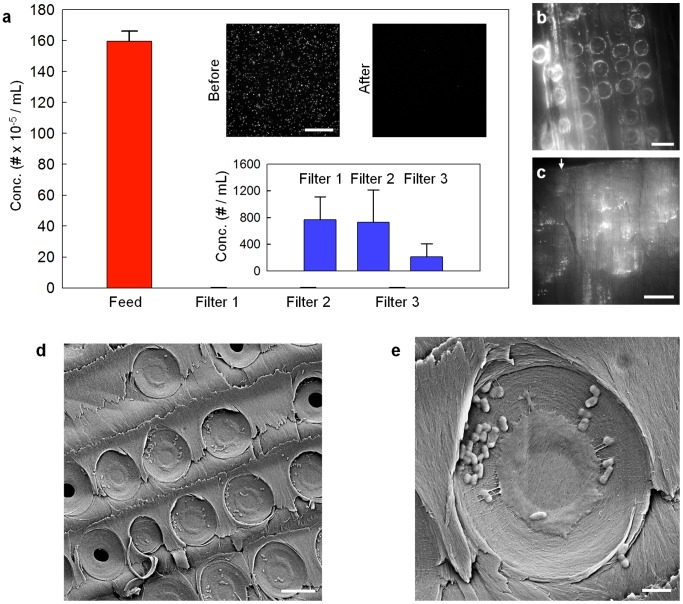
Filtration of model bacteria by the xylem filter.a) Concentrations of bacteria in the feed and filtrate solutions. Inset shows fluorescence images of the two solutions. Scale bar is 200 µm. Error bars indicate ±S.D. for experiments performed on three different xylem filters. b) Fluorescence image of xylem filter cross-section showing accumulation of bacteria over the margo pit membranes. Scale bar is 20 µm. c) Low-magnification fluorescence image shows that bacteria are trapped at the bottoms of tracheids within the first few millimeters of the top surface. Scale bar is 400 µm. Arrow indicates top surface of the xylem filter and also the direction of flow during filtration. Autofluorescence of the xylem tissue also contributes to the fluorescence signal in (b) and (c). d), e) SEM images showing bacteria accumulated on the margo pit membranes after filtration. Scale bars are 10 µm and 2 µm, respectively.